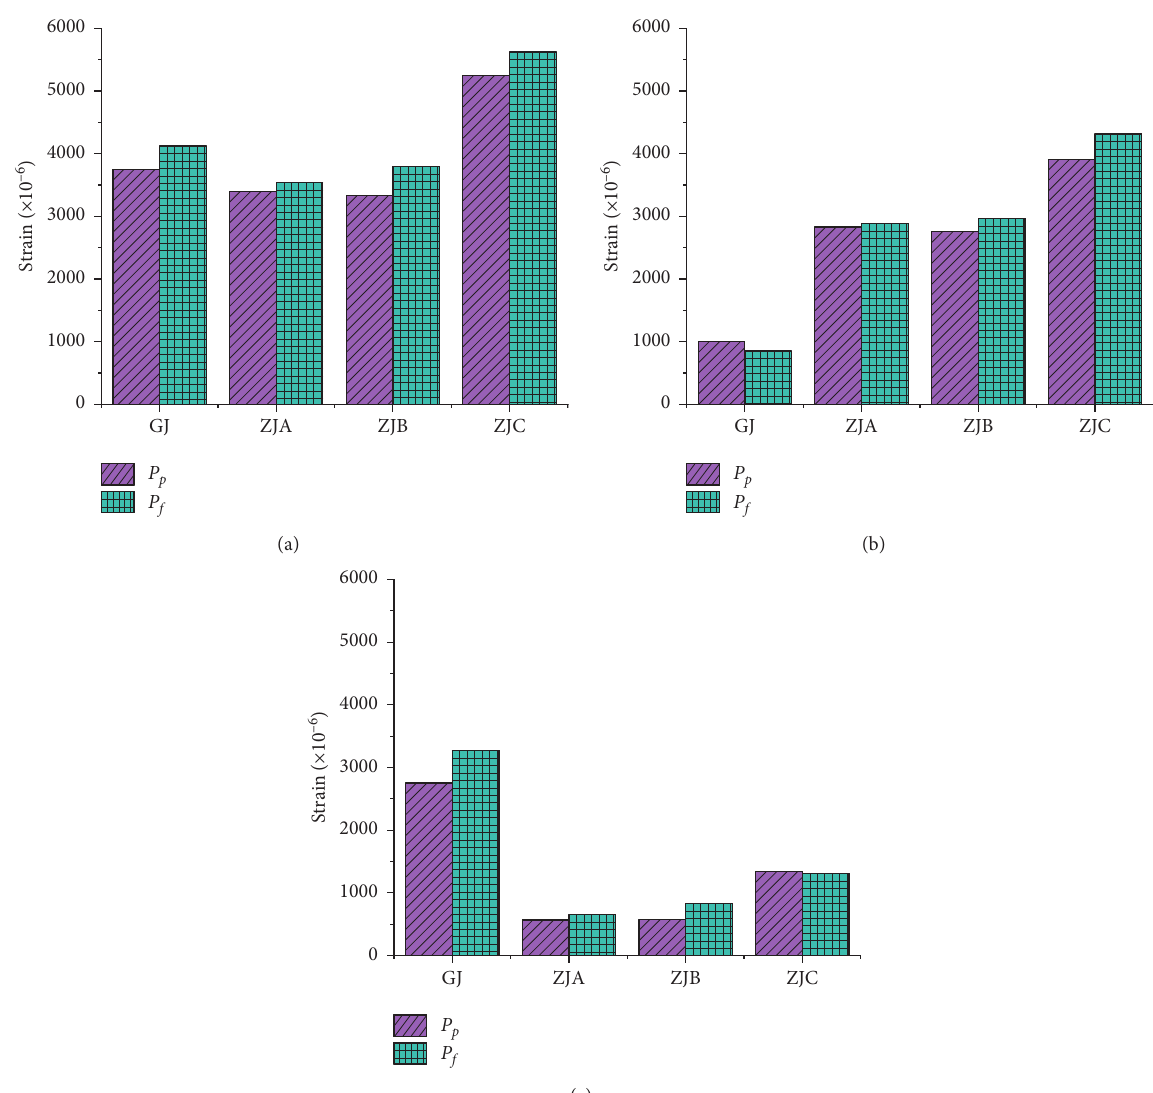
Figure 15: Comparison diagram of strain: (a) average strain of concrete column; (b) average strain of longitudinal bar; (c) difference average of concrete column’ strain and longitudinal